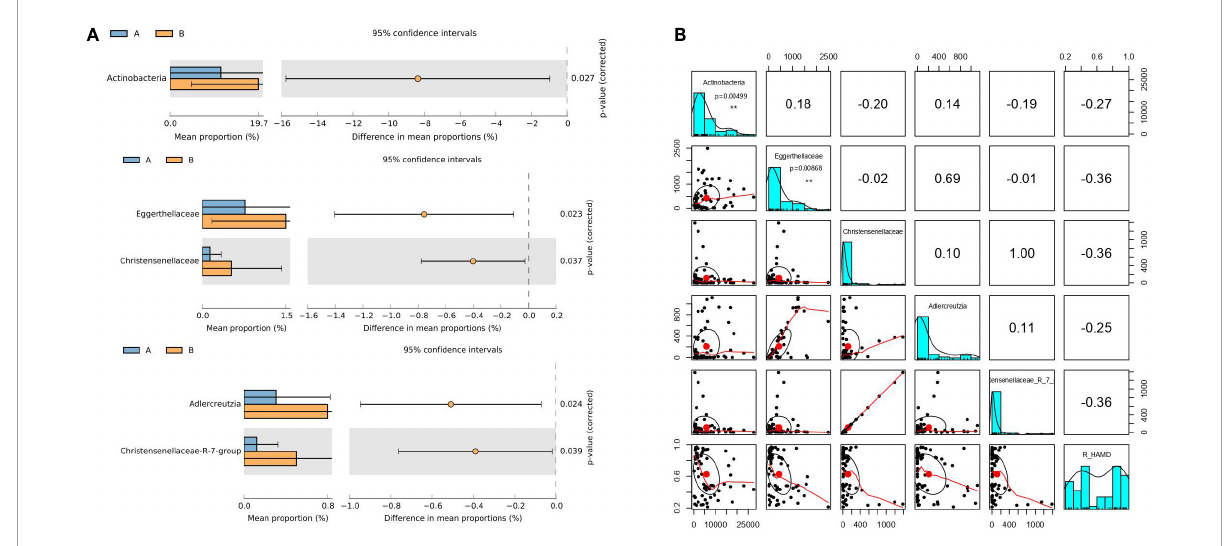
FIGURE2 Gut microflora at baseline differed between responder and non-responder groups. (A) Significantly different species according to FDR-adjusted p -values, calculated using Welch’s t -test. The mean abundance in the blue (yellow) community differed between responder and non-responder groups. (B) Correlation of R_HAMD with differential species ( R 2 = 0.3256), negative correlation with Actinobacteria ( p = 0.00499), Eggerthellaceae ( p = 0.00868), Christensenellaceae , Adlercreutzia , and Christensenellaceae R7 group . ** p <